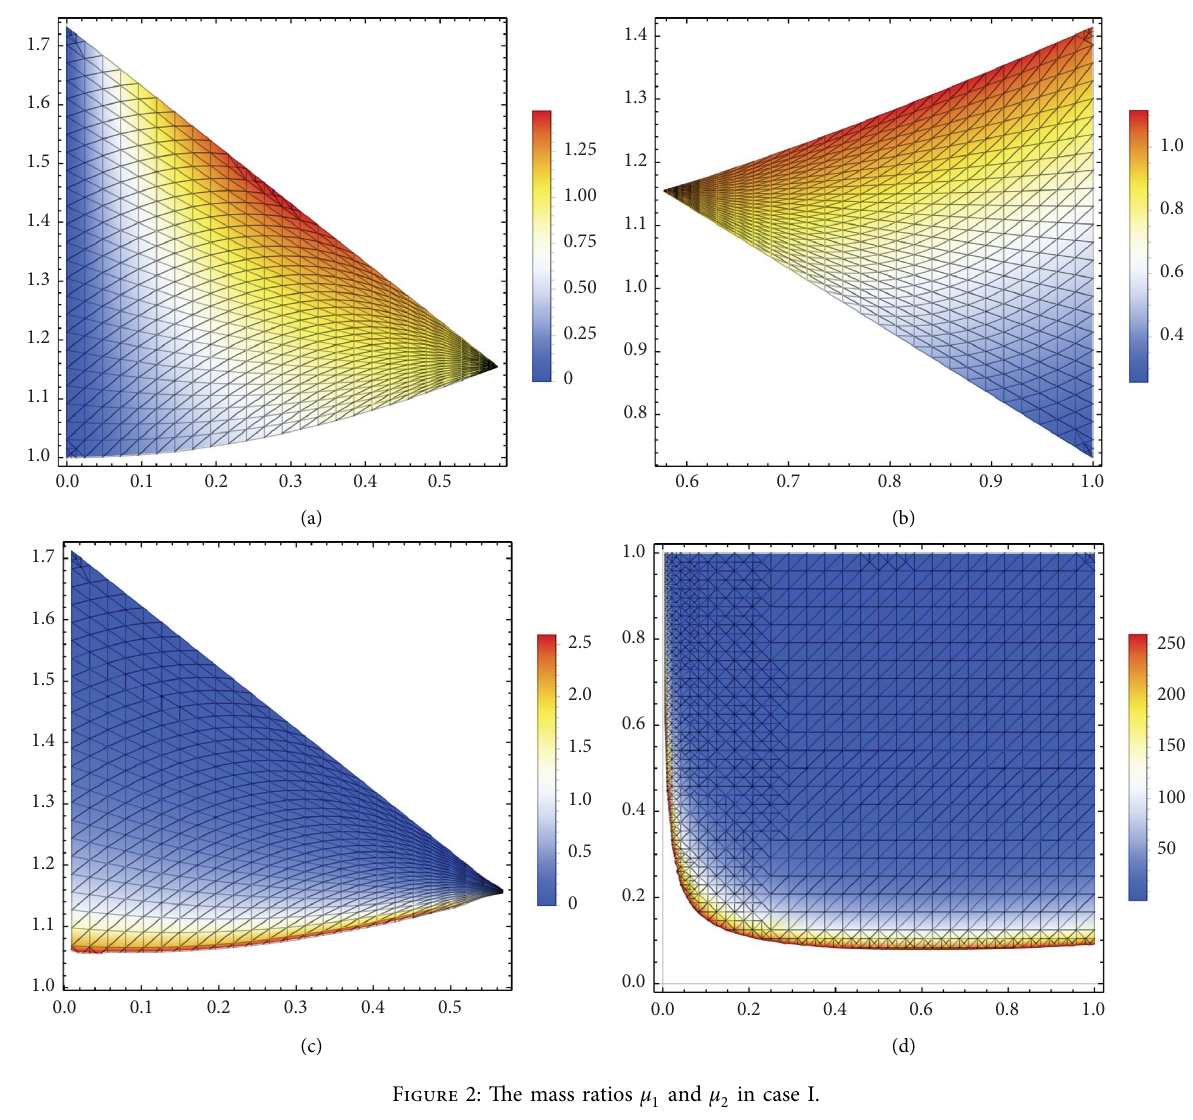
and μ in case I. 1 2